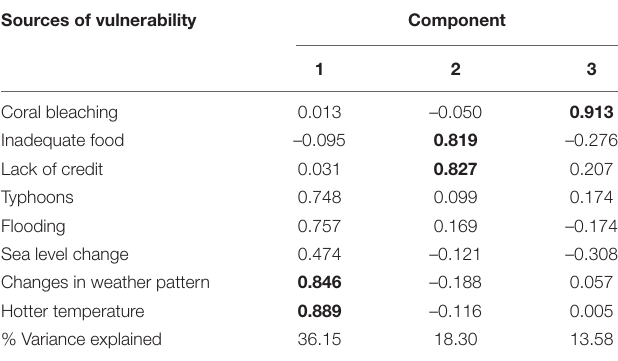
TABLE 4 | Factors loadings of the PCA results of variables related to climate change vulnerability (numbers in bold contribute highly and positively to a